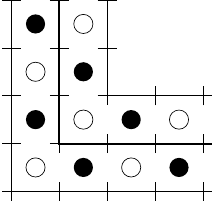
Figure 26. L-bend road.